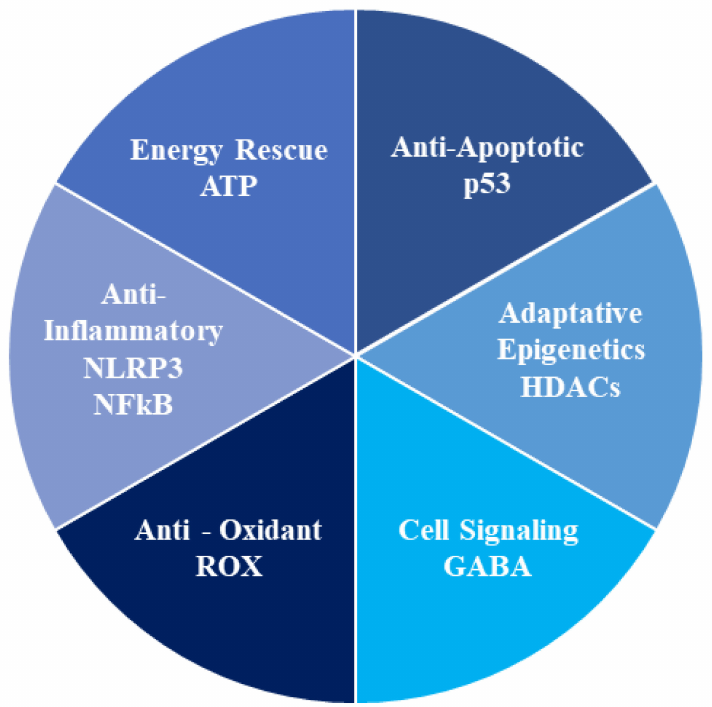
Figure 5. The six hallmarks of ketonic action. ATP: Adenosine triphosphate; NLRP3: NOD-, LRR-